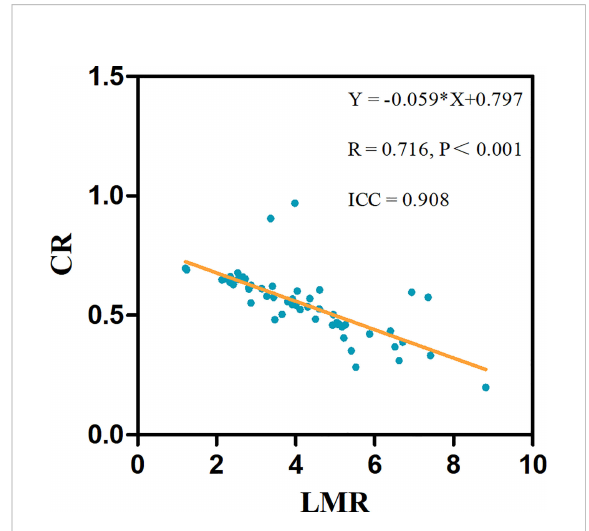
FIGURE 2 The linear associations signi fi cantly differed between the LMR and CR in 53 test patients. The linear regression equations and correlation coef fi cient R values are provided.